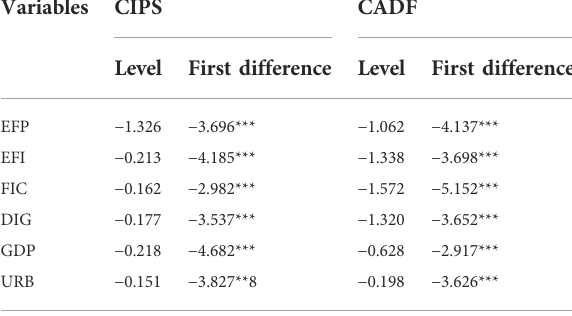
TABLE 3 CIPS and CADF unit root tests